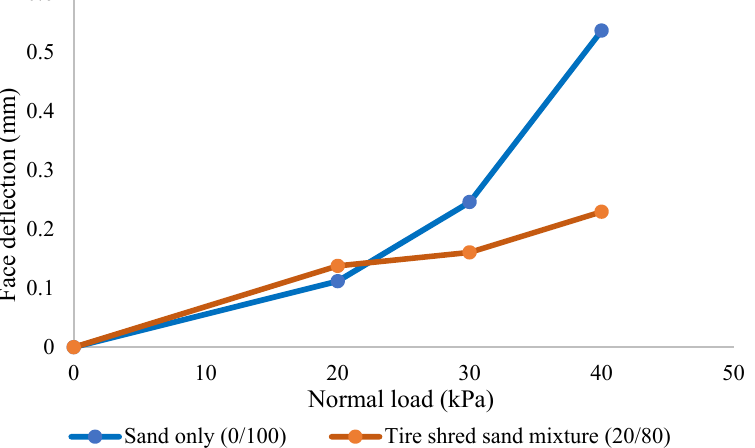
Figure 9. Comparison of wall displacement profiles for different surcharge pressures on tire shred- sand mixtures (20/80) and sand only (0/100).